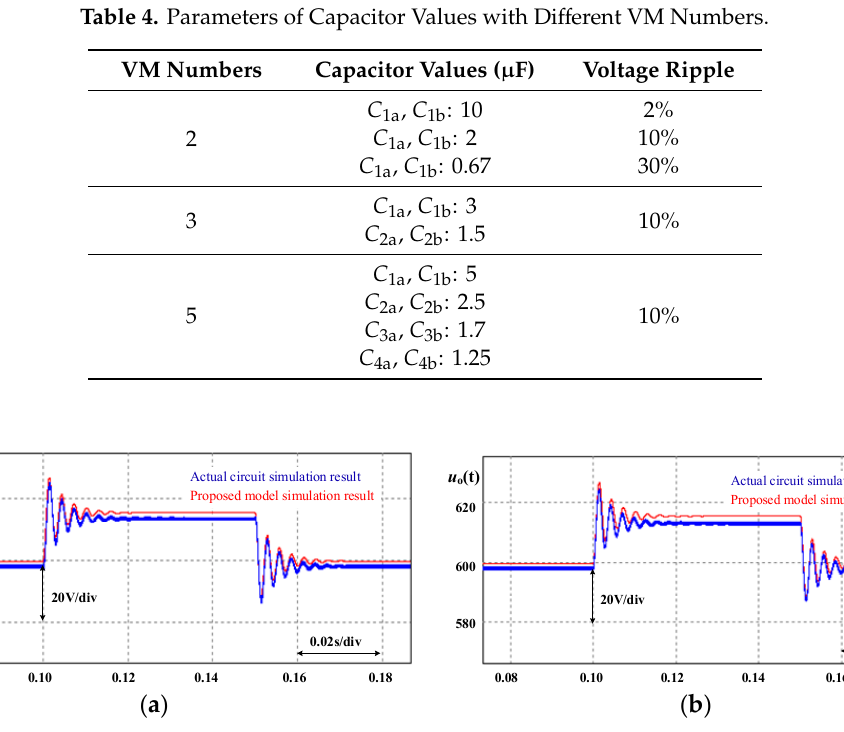
Figure 8. VM number is 3, C na = C nb = 2 μ F, and ( a ) duty cycle changes; ( b ) input voltage changes.